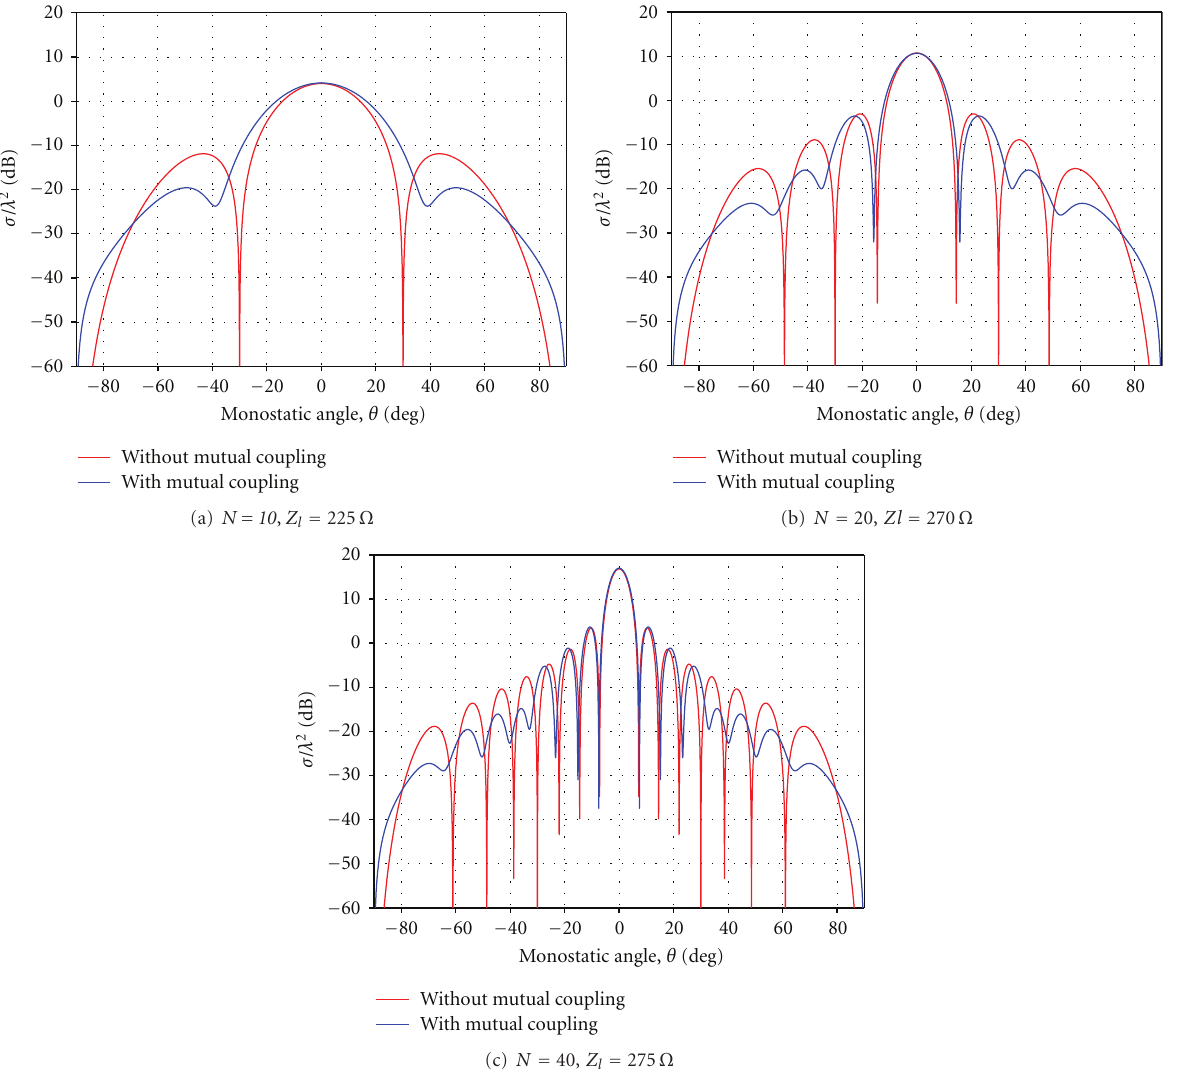
Figure 17: E ff ect of mutual coupling on RCS of series-fed linear array. θ s = 0 ◦ , ψ = π/ 2, d = 0 . 1 λ , l = 0 . 5 λ , a = 10 − 5 λ , and Z 0 = 150 Ω with unit amplitude uniform distribution for side-by-side configuration